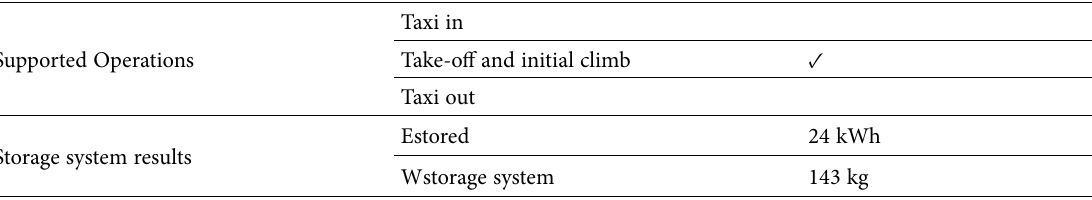
Supported Operations